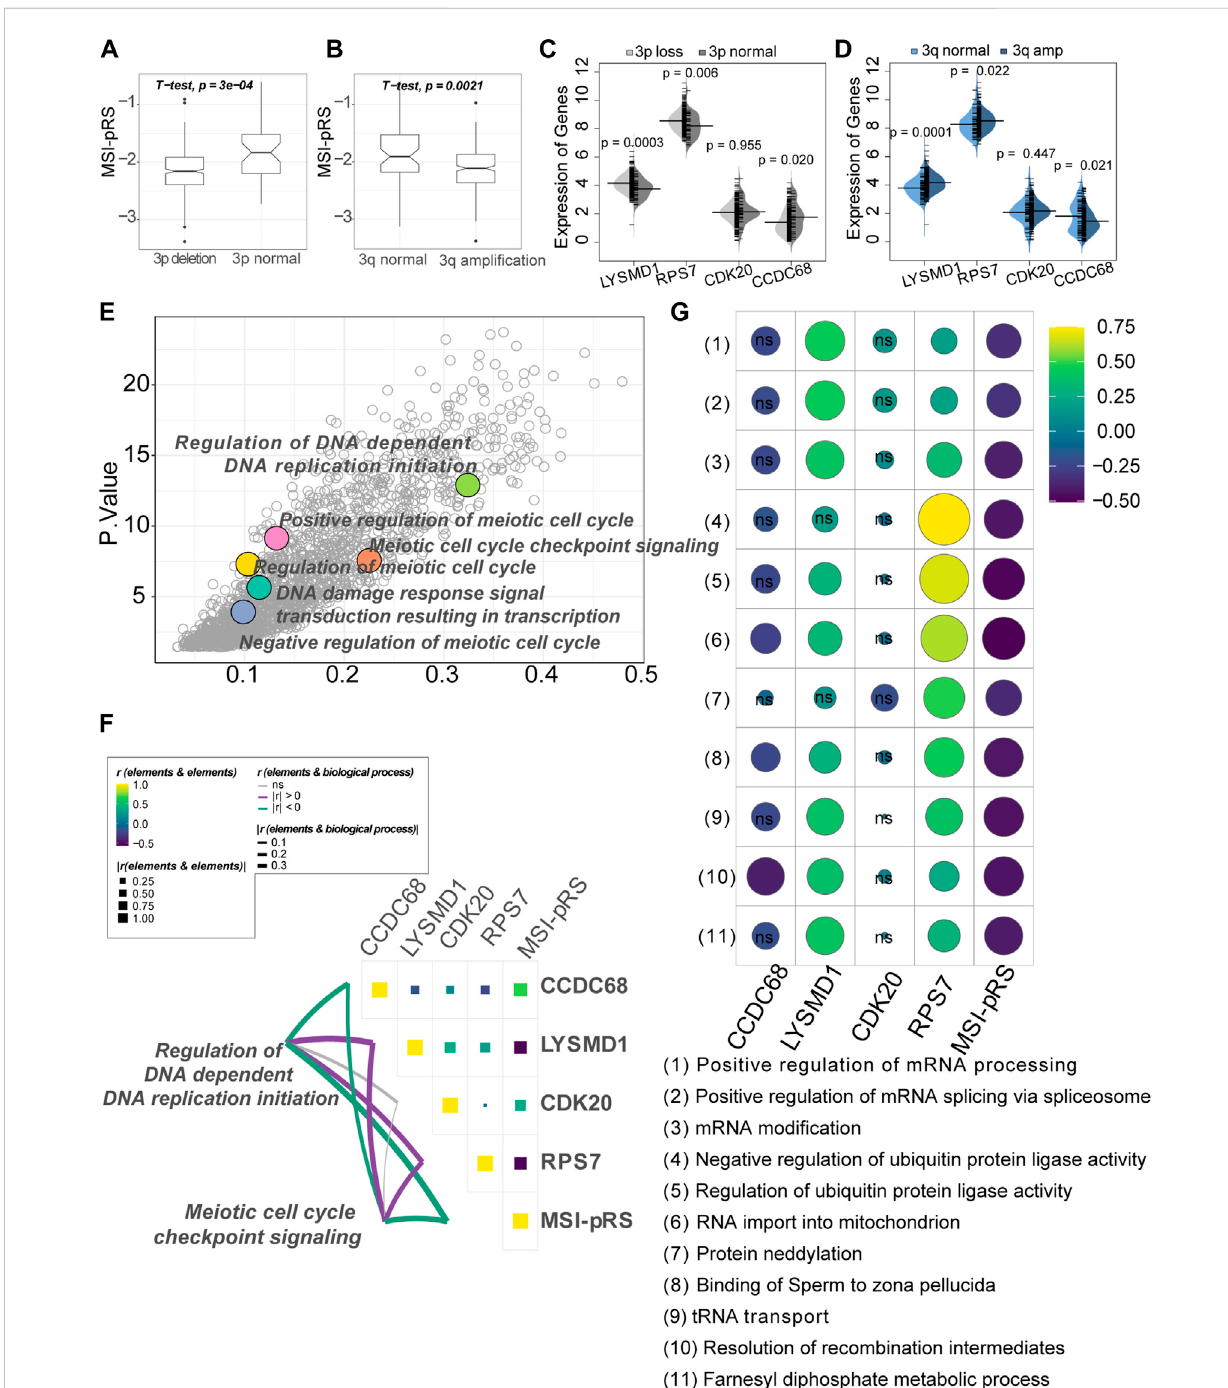
FIGURE 11 Genomic feature exploration of the MSI-related prognostic risk score (MSI-PRS). (A) MSI-pRS was lower in the chromosome 3p deletion LUSC. (B) MSI-pRS was lower in the chromosome 3q ampli fi cation LUSC. (C) Comparison of the four elements used to construct the MSI-pRS model between 3p lossand3pnormalgroups.LYSMD1andRPS7werehigherinthe3plossgroup,whileCCDC68waslowerinthe3plossgroup. (D) Comparison ofthefour elements used to construct the MSI-pRS model between 3q ampli fi cation and 3q normal groups. LYSMD1 and RPS7 were higher in the 3q ampli fi cation group, while CCDC68 was lower in the3q ampli fi cation group. (E) DNA replication, DNA damage response, and cell cycle checkpoint were upregulatedintheMSI-pRSlowgroup.LowMSI-pRSwasassociatedwithhighgenomicinstabilitywithactiveDNAdamagerepairresponse,whereashigh MSI-pRS was vice versa . (G) Correlation of MSI-pRS and the transcriptional/ translational control associated biological processes. High MSI-pRS was negatively associated with transcriptional/translational control. LYSMD1 and RPS7 were positively correlated with the previously described processes. (F) Correlation of the MSI-pRS and its four elements. LYSMD1 and RPS7 were negatively correlated with the MSI-pRS, while CCDC68 and CDK20 were positively correlated with theMSI-pRS. Correlation of the MSI-pRS and four elements and DNAreplication and cell cycle checkpoint processes. MSI-pRS and CCDC68 negatively related to the processes, whereas LYSMD1 and RPS7 were positively